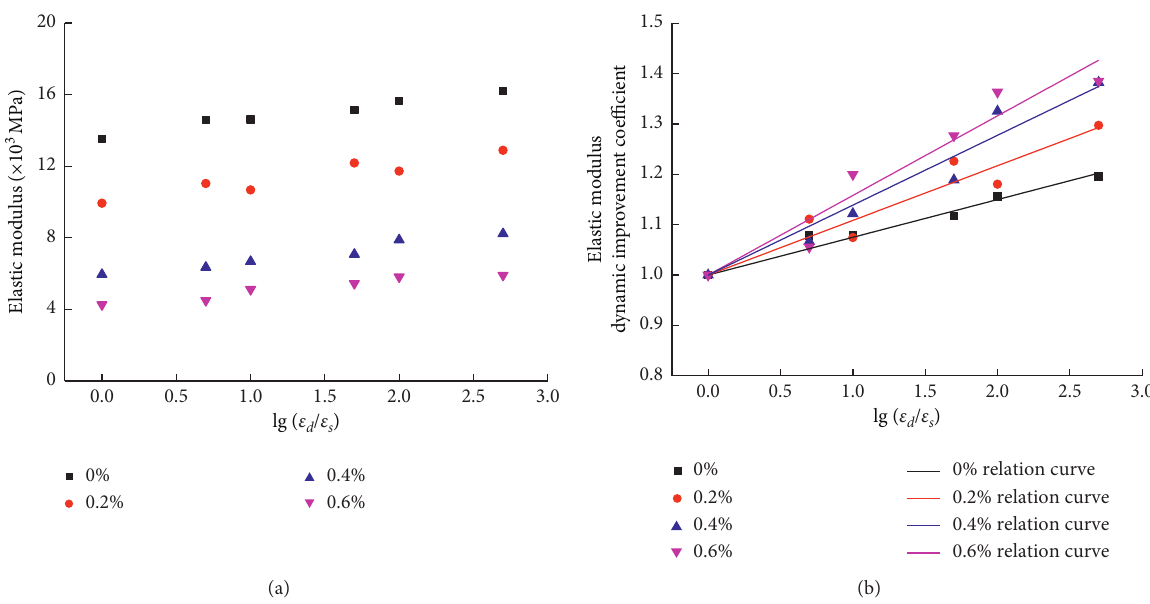
Figure 9: Elastic modulus of polypropylene fiber reinforced concrete under different loading conditions. (a) Elastic Modulus. (b) Elastic Modulus dynamic improvement